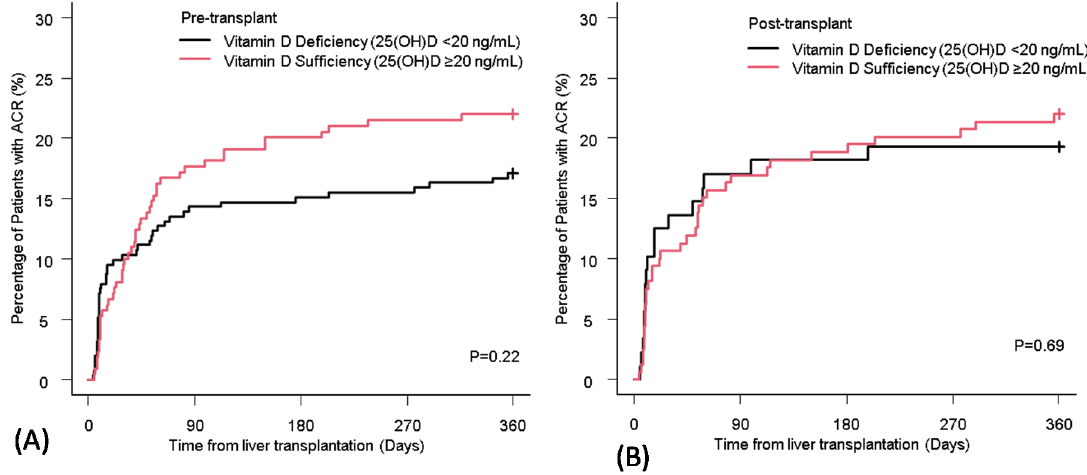
Figure 3. The cumulative incidence of ACR in liver transplant recipients with vitamin D deficiency and sufficiency at pre-transplant ( A ) and post-transplant ( B ). ACR: acute cellular rejection; 25(OH)D: 25-hydroxy vitamin D.